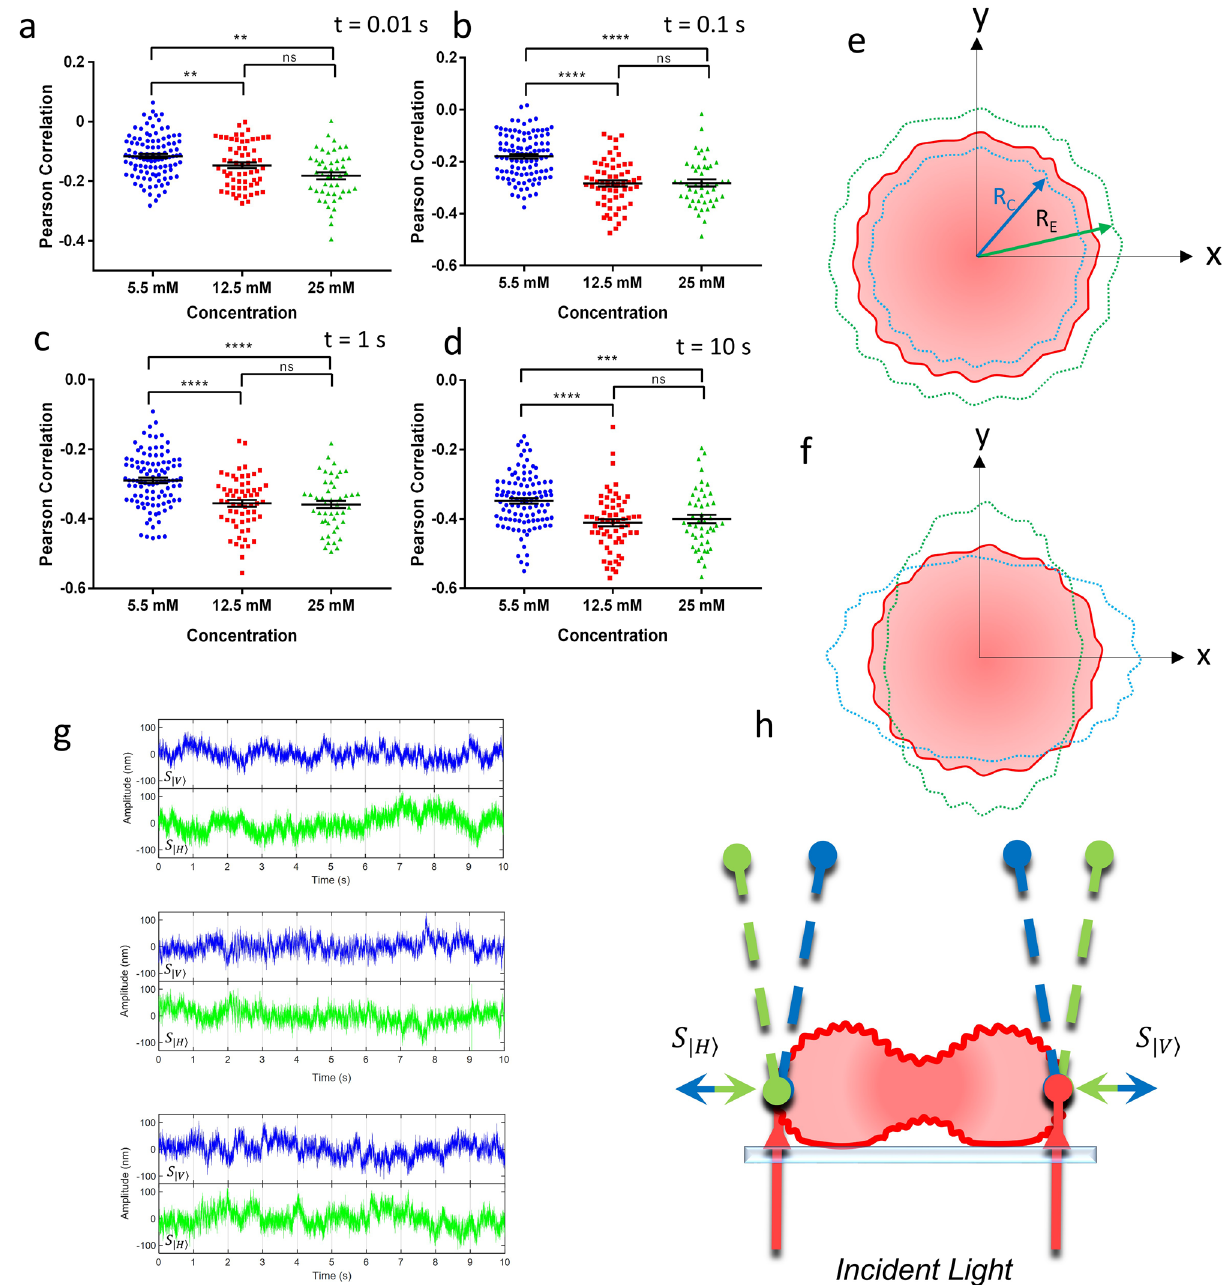
Figure 2. Signal Pearson’s correlation for RBCs at different D-glucose concentrations. ( a – d ) Correlations at different time windows associated with different low frequencies ( GraphPad Prism ver. 7 ). ( e , f ) Two different interpretations of anticorrelated motions. ( e ) is associated with a volume change (radial expansion and contraction, R E and R C , respectively), and ( f ), orthogonal vibration mode, with the dashed blue and green lines showing orthogonal deformation. ( g ) Temporal fluctuation signal amplitude S | H � (green) and S | V � (blue) for 5.5, 25.5, and 25 mM of glucose concentration with Pearson’s anticorrelation values of -0.38, -0.46, and -0.40, respectively ( Matlab ver. 2018b ). ( h ) Lateral view of Laser deflection. Discocyte Cell membrane beating (blue and green arrows) displaces both beam lasers in opposite directions to photodetectors. Small ripples in the membrane represent the high-frequency thermal